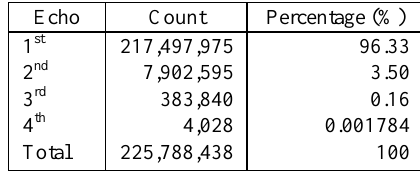
Table 1. Echo distribution of acquired ALS